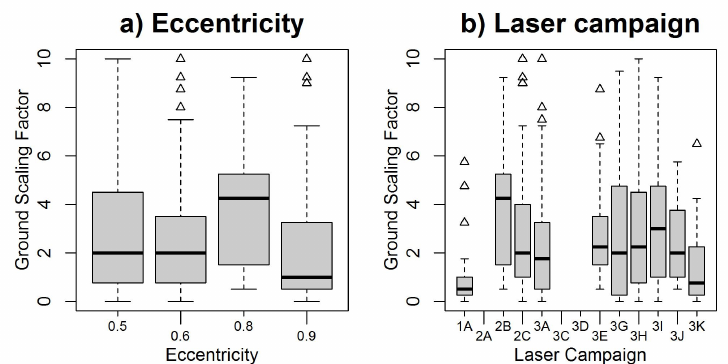
Figure 4. Boxplots illustrating how GLAS scaling factors vary as a function of ( a ) footprint eccentricity and ( b ) laser campaign (Lc). Boxes indicate the median (black line), first (Q1) and third (Q3) quartiles (lower and upper box edges, respectively), up to 1.5-times the Interquartile Range (IQR) beyond the box (whiskers) and outliers greater than 1.5-times the IQR beyond the box (triangles). Note that whiskers extend to a point, which is no more than 1.5-times the IQR from the box; if no outliers exist beyond this range, the whiskers are truncated and do not always appear symmetrical as a result.